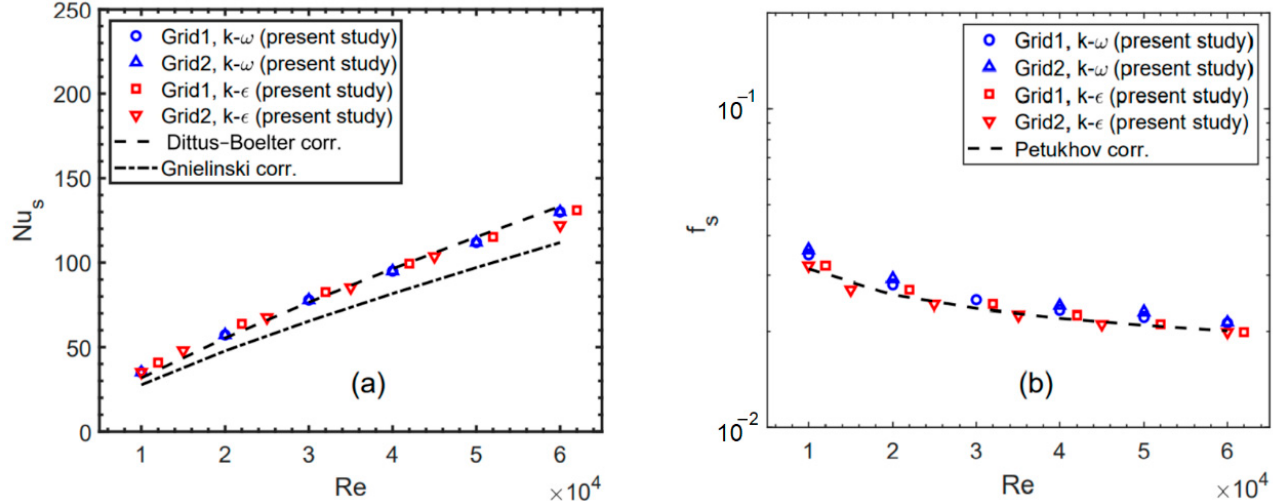
Figure 4. Verification of the present study of a smooth tube: ( a ) Nusselt number at Pr = 0.71 and ( b ) friction factor.